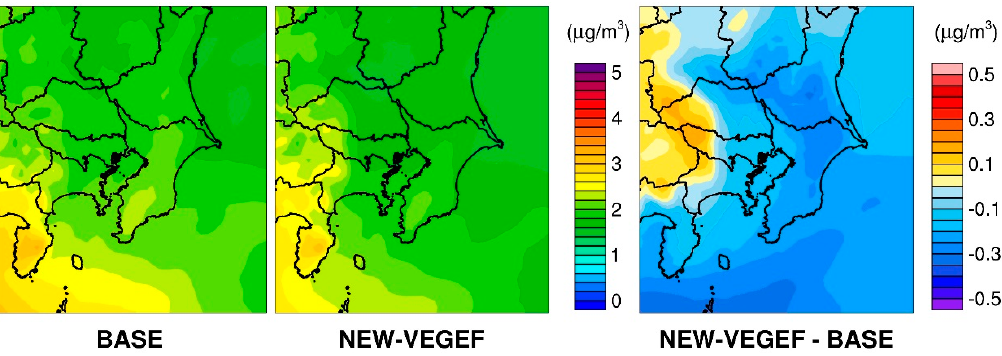
Figure 9. Horizontal distributions of mean surface SOA concentrations simulated in the BASE and NEW-VEGEF cases during the target period in d04. Differences between the two cases are also shown.